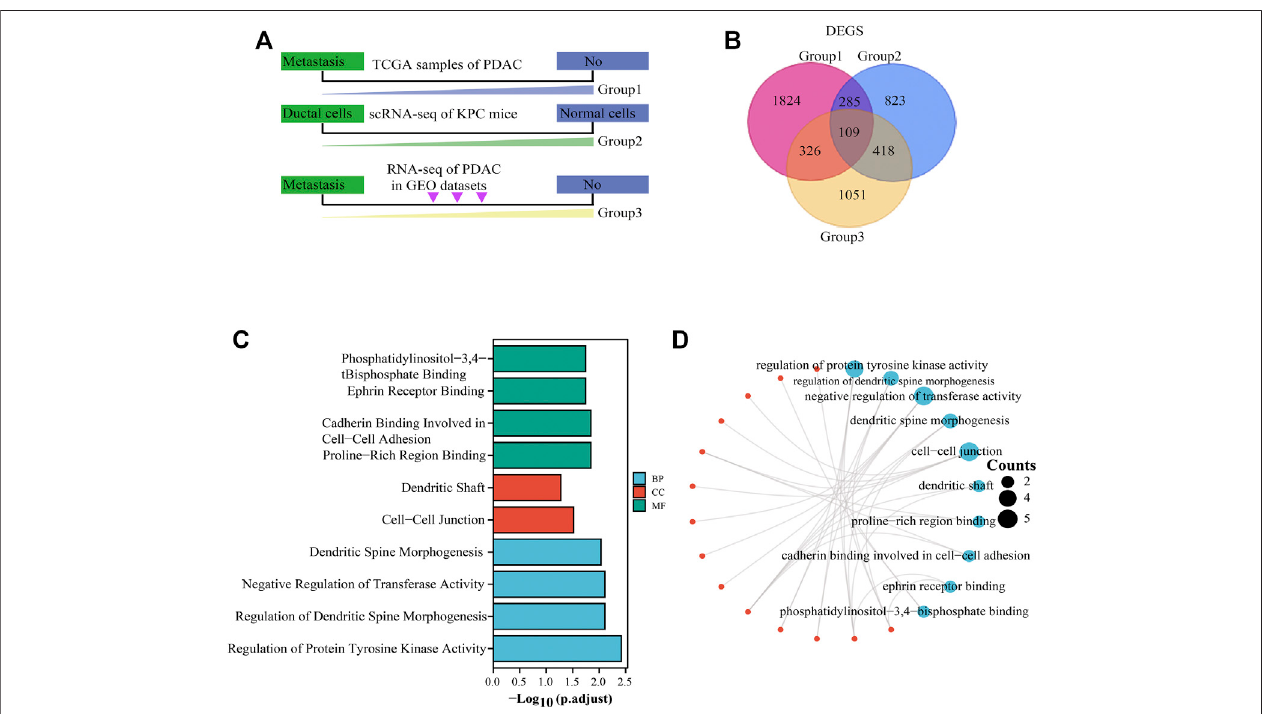
FIGURE 1 | DEG screening and functional enrichment analysis. (A) : Work fl ow of DEG screening. Group 1 represents TCGA sample screening (divided into “ with metastasis ” and “ withoutmetastasis ” group), group 2representsKPCmouse single-cell transcriptomesequencing(divided into “ ductalcells ” and “ normal cells ” group), and group3represents GEOdatasample(dividedinto “ withmetastasis ” and “ withoutmetastasis ” group). (B) :Concomitant upregulatedDEGsingroup1,group2,and group 3. Red indicates group 1, blue indicates group 2,and yellow indicates group 3. (C) :GO analysis ofupregulatedDEGs. Green representsBP, red represents CC, and blue represents MF. Adjusted p < .05. (D) : Network diagram of GO analysis of upregulated DEGs. The red dots represent the interacting genes, and the blue dots represent the ID of the pathway, and the number of genes is represented by the size of the circle. DEGs: differentially expressed genes.